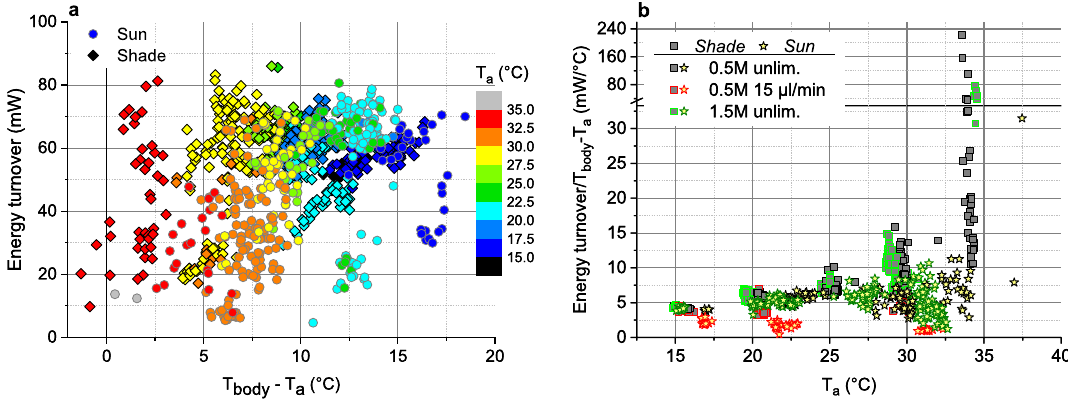
Figure 3. Energetics of honeybees foraging in shade (≤ 100 W m −2 ) or in sunshine (> 100 W m −2 ), from simultaneous measurements of CO 2 production and body surface temperature (T body = mean of head, thorax and abdomen). ( a ) Energy turnover of sucrose gathering honeybees in dependence on body temperature excess (elevation of mean body temperature per stay above ambient air temperature: T body –T a ). For measured thorax temperatures see Fig. 2. ( b ) Heat conductance estimate from these data in dependence on ambient air temperature (T a ). Bees fed 1.5 M sucrose in unlimited flow (data from 17 ), and 0.5 M sucrose solution in unlimited flow or limited flow of 15 µl min −1 (data from 18 ).